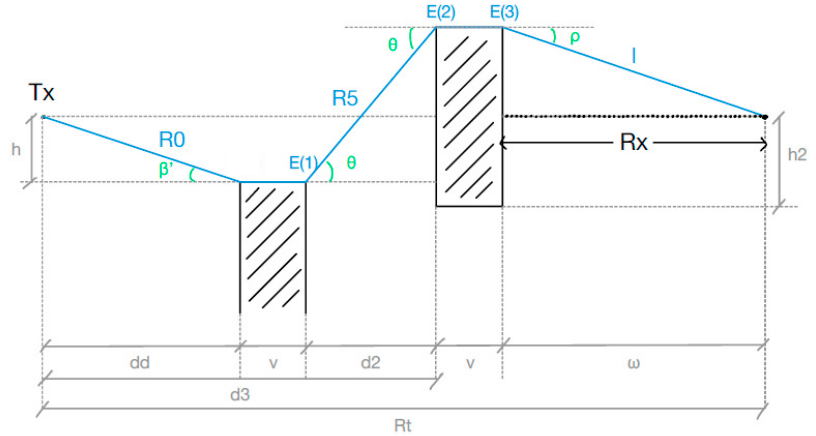
14 of 22 Figure 22. First quadruple diffraction (Edif_q1) of the second considered NLOS scenario. 𝐸𝑑𝑖𝑓_𝑞1 = 𝐸(3)𝐷 (cid:3436)𝜑 (cid:4593) = 0; 𝜑 = 𝜋 + 𝜌; 𝐿 = (𝑅0 + 2𝑣 + 𝑅3)𝑙 𝑅0 + 2𝑣 + 𝑅3 + 𝑙(cid:3440) (cid:3496) 𝑅0 + 2𝑣 + 𝑅3 𝑙(𝑅0 + 2𝑣 + 𝑅3 + 𝑙) 𝑒 (cid:2879)(cid:3037)(cid:3038)(cid:3039) (41) where 𝐸(3) = 𝐸(2)𝐷 (cid:3436)𝜑 (cid:4593) = 𝜋 2 − 𝜏; 𝜑 = 3𝜋 2 ; 𝐿 = (𝑅0 + 𝑅3 + 𝑣)𝑣 𝑅0 + 𝑅3 + 2𝑣 (cid:3440) (cid:3496) 𝑅0 + 𝑅3 + 𝑣 𝑣(𝑅0 + 𝑅3 + 2𝑣) 𝑒 (cid:2879)(cid:3037)(cid:3038)(cid:3049)